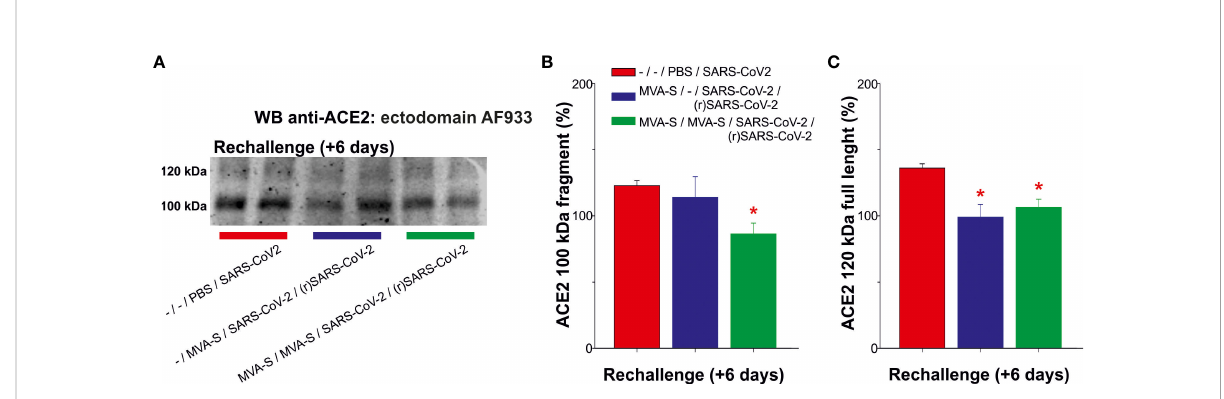
FIGURE 3 Outcome of SARS-CoV-2 reinfection in serum ACE2 levels of MVA-CoV2-S vaccinated K18-hACE2 mice that recovered from a fi rst virus infection. To determine the effect of a second virus inoculation, mice vaccinated with one or 2 doses of MVA-CoV2-S (n= 5/group), were rechallenged with the lethal dose of SARS-CoV-2, 7 weeks after the fi rst SARS-CoV-2 infection. Unvaccinated mice (n= 5) were also challenged with the virus, dying at day 6 post-challenge. Individual mouse serum samples collected 6 days after re-challenge [(r)SARS-CoV-2] were analyzed. (A) Representative ACE2 immunoblot for samples at indicated situation resolved with the ectodomain AF933 antibody. (B, C) Densitometric quanti fi ed for the cleaved 100 kDa fragment (B) and for the full-length 120 kDa (C) species. All samples were analyzed at least in duplicate in separate blots. Signi fi cant p values ( p < 0.05) respect to unvaccinated and challenged mice (*;